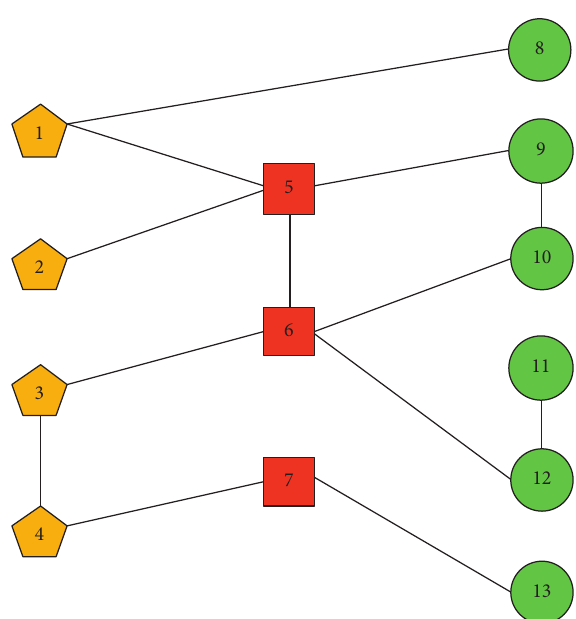
Figure 1: Illustration of the supply network